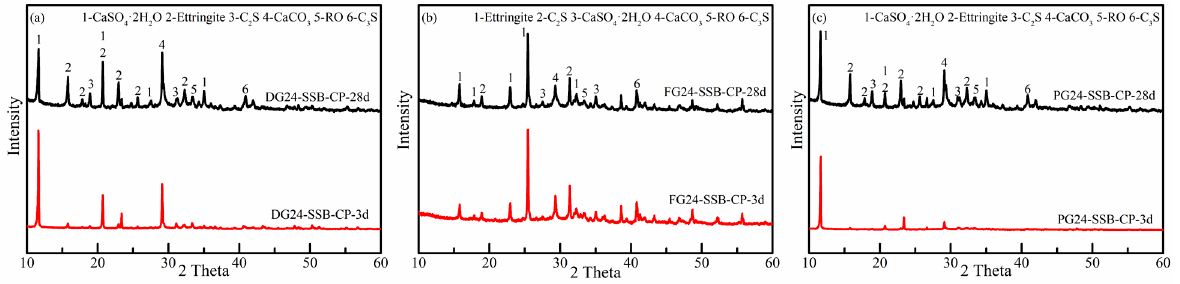
Figure 8. XRD pa tt ern for hardened SSB-CP with di ff erent gypsums: ( a ) DG24-SSB-CP-3d, ( b ) Figure 8. XRD pattern for hardened SSB-CP with different gypsums: ( a ) DG24-SSB-CP-3d, ( b ) FG24- FG24-SSB-CP-3d, and ( c ) PG24-SSB-CP-3d. SSB-CP-3d, and ( c )